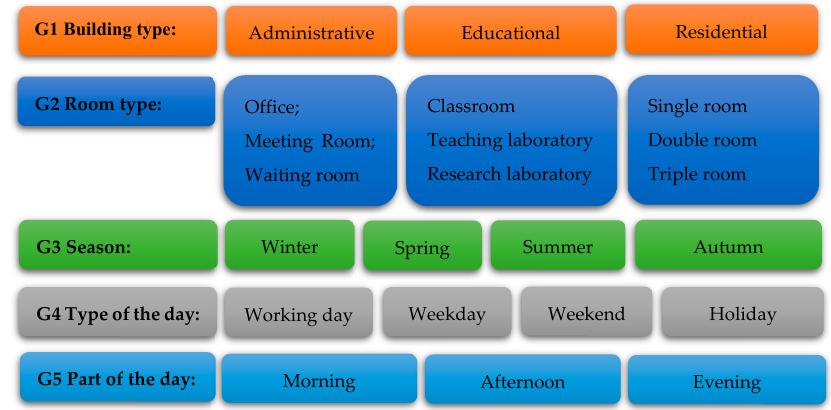
Figure 11. Groups in the Context-Based Reasoning (CBR) model.